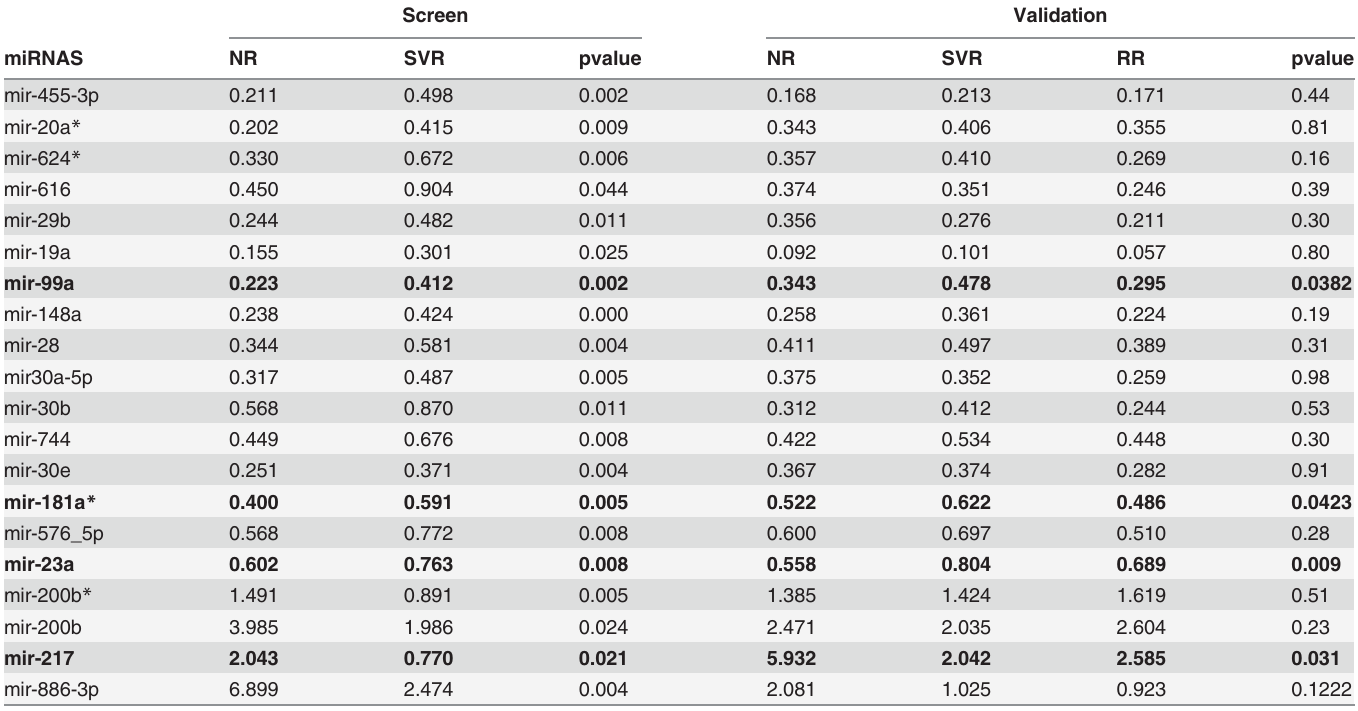
Table 2. Differentially expressed miRNAs between NRs, SVRs and RR, prior to treatment. Screen Validation